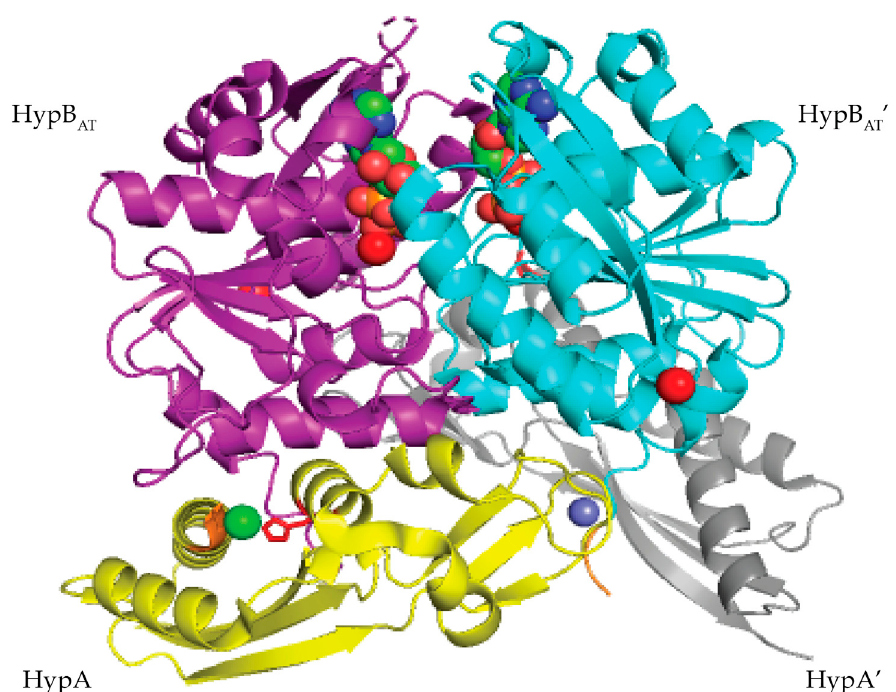
Figure 13. Crystal structure of the transient HypAB complex from T. kodakarensis (PDB ID 5AUN) [101]. The protein was crystallized from a solution containing equal molar concentrations of T. kodakarensis HypA and HypB in the presence of ATP γ S and nickel chloride. The HypA monomers (shown in yellow and gray) bind on either site of the HypB dimer (shown in purple and cyan). The nickel ion is shown as a green sphere and is coordinated by the MHE motif (colored orange) and His98 (colored red) of HypA. The zinc ion is shown as a slate sphere, the magnesium ion as a red sphere, and the ADP molecules are shown as red, green, and blue spheres. (This figure is adapted from Watanabe, S.; Kawashima, T.; Nishitani, Y.; Kanai, T.; Wada, T.; Inaba, K.; Atomi, H.; Imanaka,